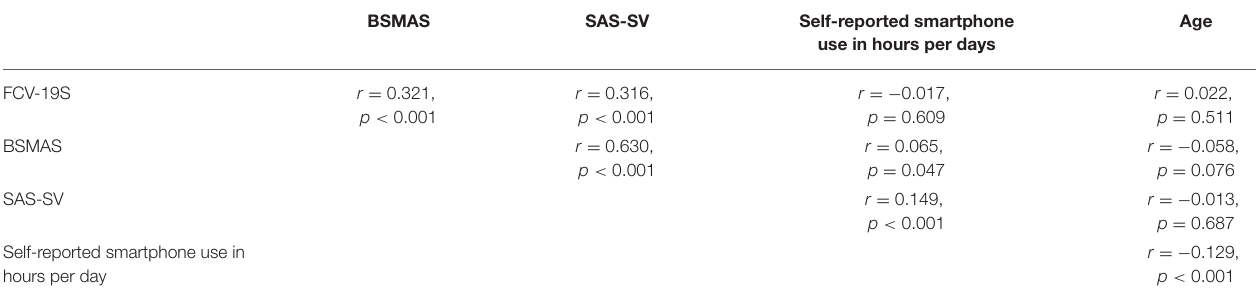
BSMAS SAS-SV Self-reported smartphone r = 0.316, p < 0.001 p < 0.001 p < 0.001